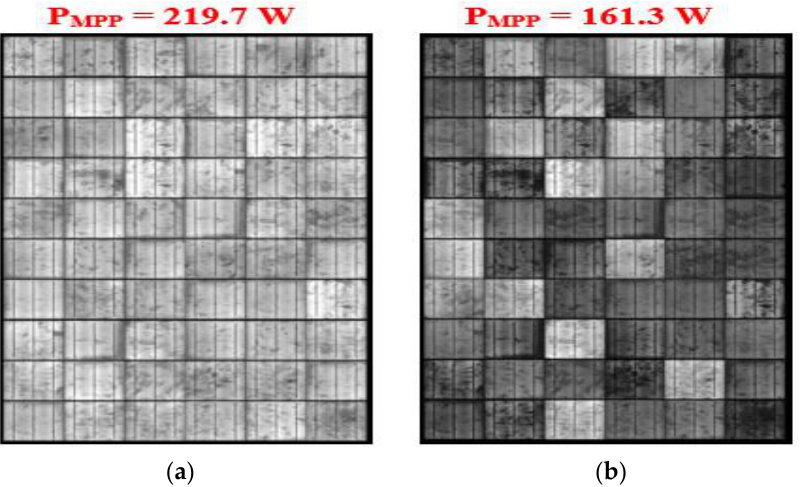
Figure 1. EL imaging of a PV module, this PID was carried out following the IEC628041 PID-testing standard, the tested PV module was under a temperature. of 60 °C with 80% humidity and subjected to a negative 1000 V load and operating under a short circuit current (8.18 A) for 96 h: ( a ) Before PID, ( b ) after PID.